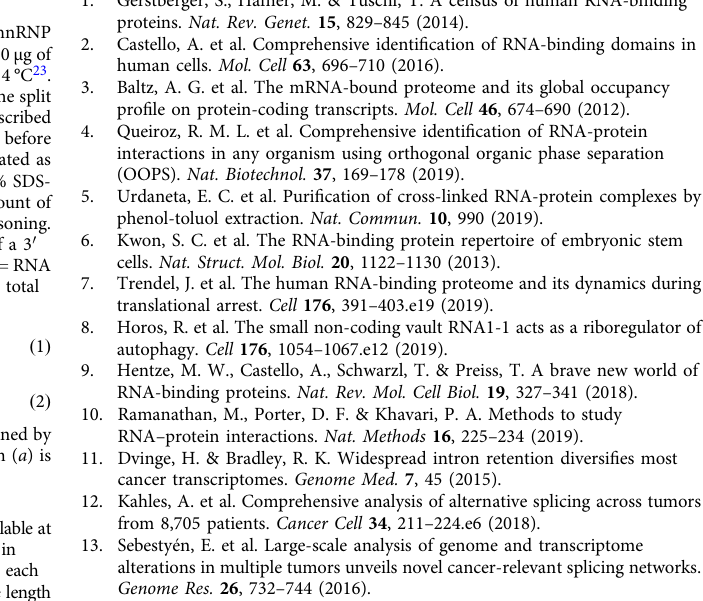
Figure 5 cell culture . Proteins included in Fig. 2 were expressed and puri fi ed in the same way. PCBP1 was stably integrated outside its genomic locus in HCT116